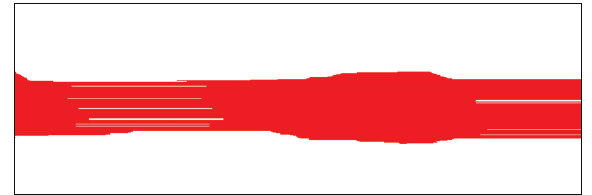
Figure 12: Erosion of principal binary image.